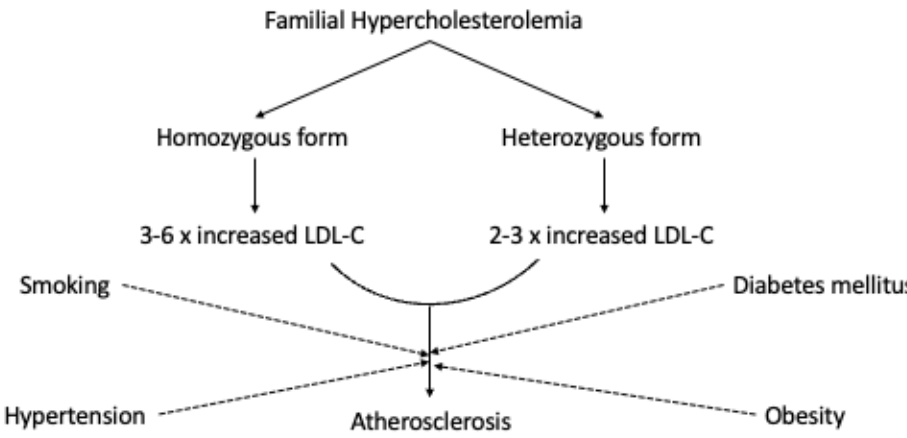
Figure 1. The potential relationship between FH and Figure 1. the potential relationship between FH and atherosclerosis.